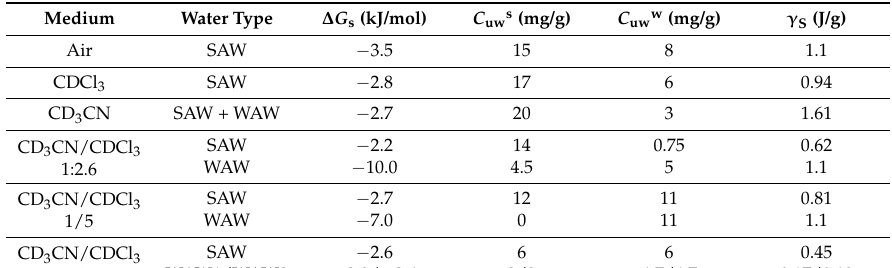
Figure 9. Amount of unfrozen water ( C uw ) as a function of temperature; and changes in the Gibbs free energy of interfacial water versus C uw at different concentrations of collagen in the hydrogel (adapted from [76] with permission, Copyright 2006, Elsevier).